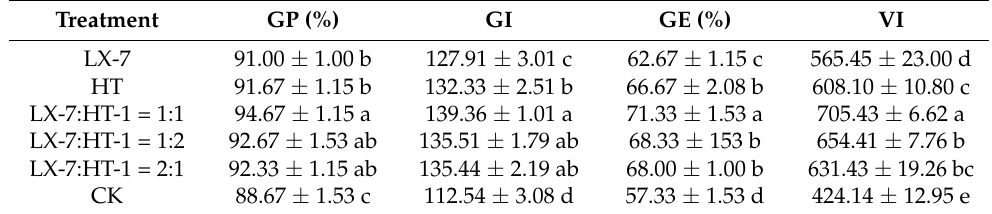
Table 2. Effects of HT-1 and LX-7 strains on germination parameters of Brassica chinensis L.